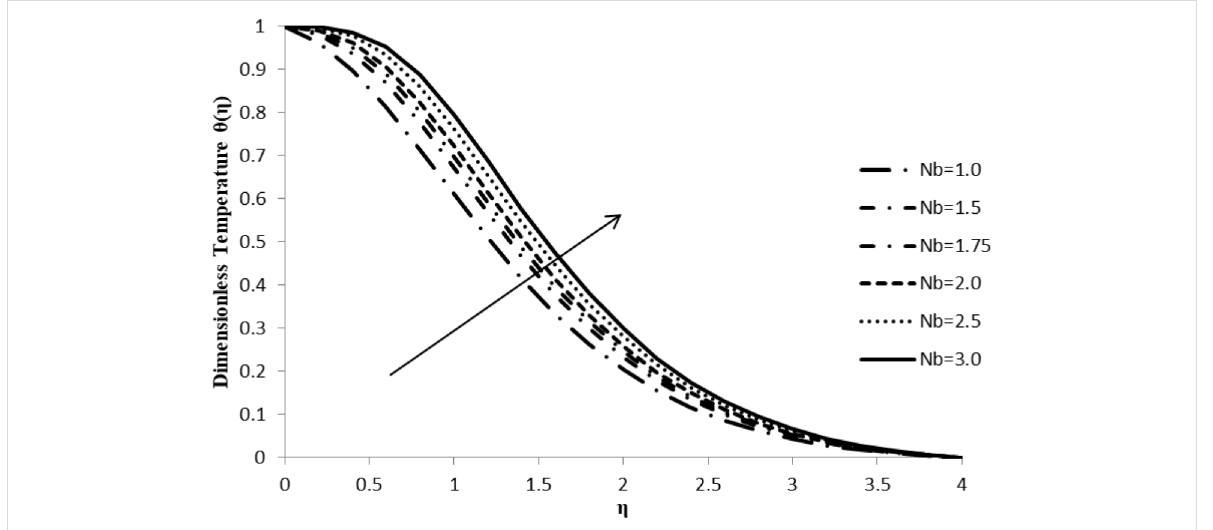
Figure 8: Influence of the Brownian motion parameter Nb on the temperature distribution, θ ( η ) when n = 2.0, ξ = 1.0, M = Q = 0.0, Pr = 2.0, Nt = 0.5, Le = 5.0, and F w = 0.2.